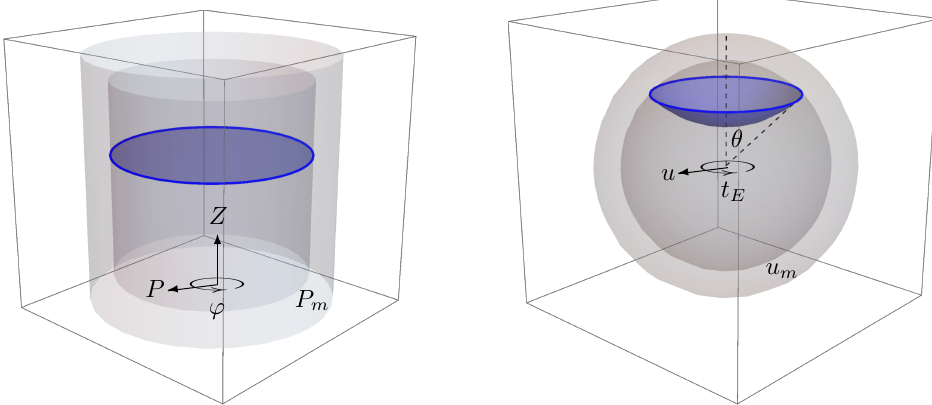
Figure 5 . Left: membrane solution (4.22) in the Euclidean cylinder with bulk cutoff P m . Right: membrane solution (4.23) in the Euclidean ball with bulk cutoff u m . The two solutions map to each other under the bulk transformations (4.20). Furthermore, to properly account for the finite cutoff, one needs to redefine α according to